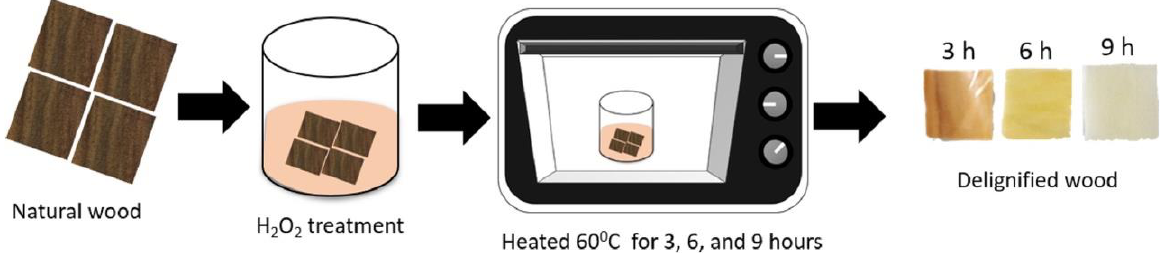
Figure 19. Scheme of the preparation of transparent wood. Reprinted with permission from [40], copyright 2022, Elsevier.